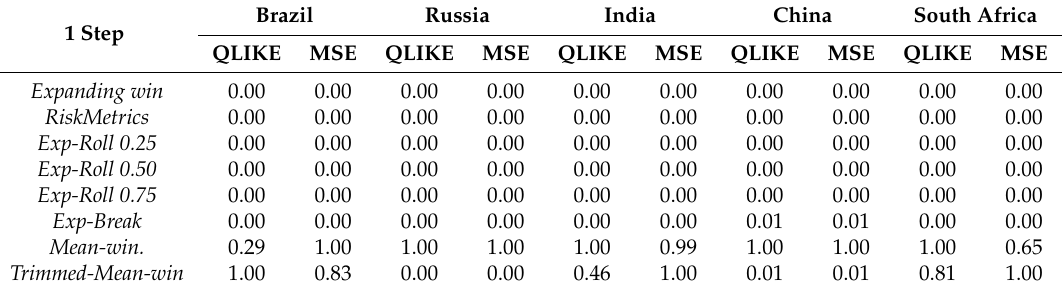
Table 4. MCS p -values for MSCI daily returns on BRICS countries. The forecasting horizon is equal to 1. The test statistic is SQ . The loss functions are MSE and